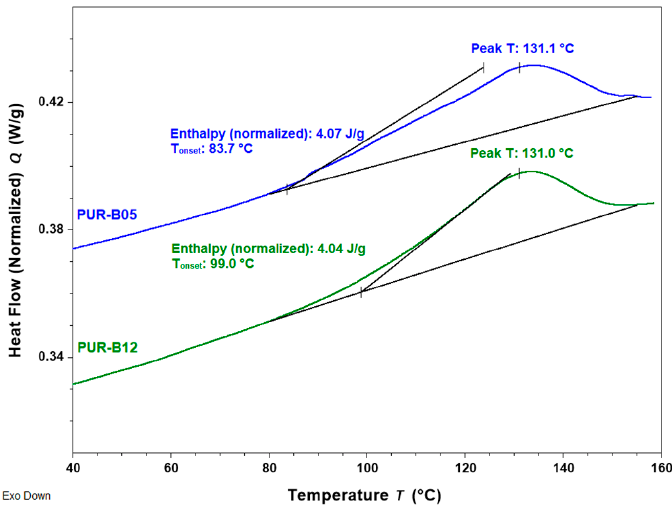
Figure 6. DSC heating curves at 10°C/min for the samples PUR-B05, 18.8% TB (with DAF) and PUR-B12, 19.9% TB (with DAR).